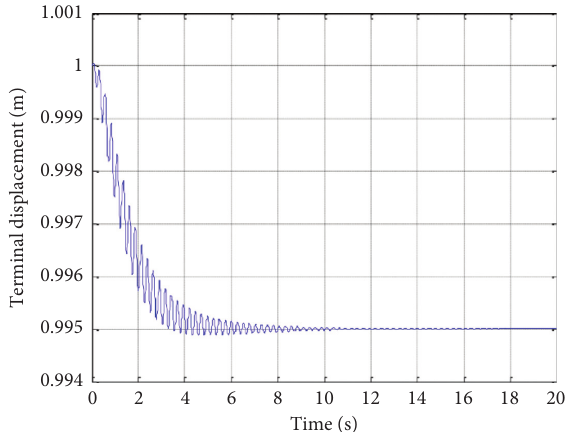
Figure 11: Control voltages V the first pair of piezoelectric actuators.